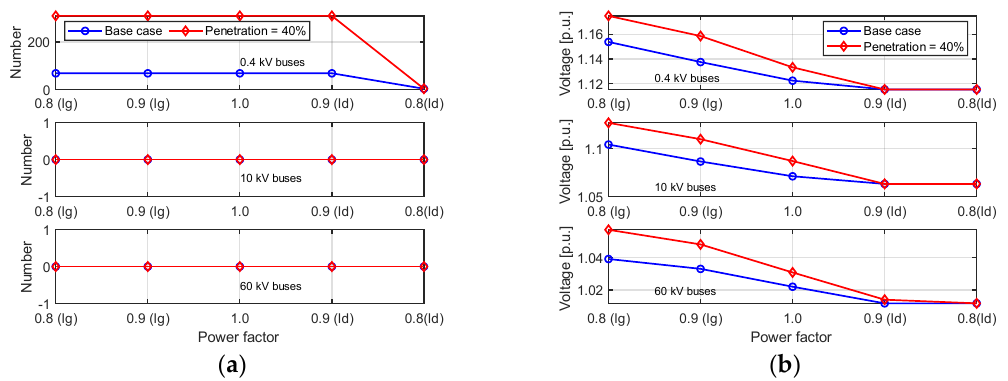
Figure 8. The worst overvoltage situations of buses at different PF setpoints (with constant PF ): ( a ) Yearly maximum number of overvoltage buses; ( b ) Yearly maximum bus voltages.